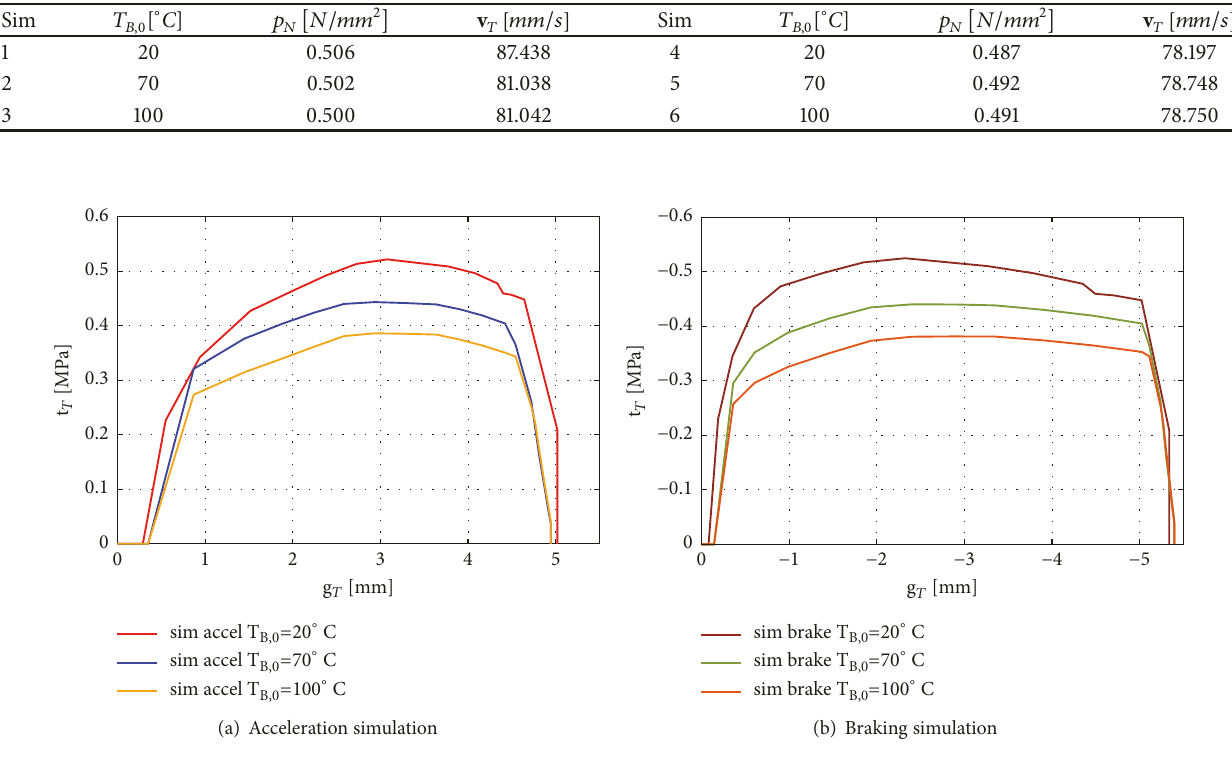
Figure 13: Tangential stresses versus slip in the acceleration and braking simulation.